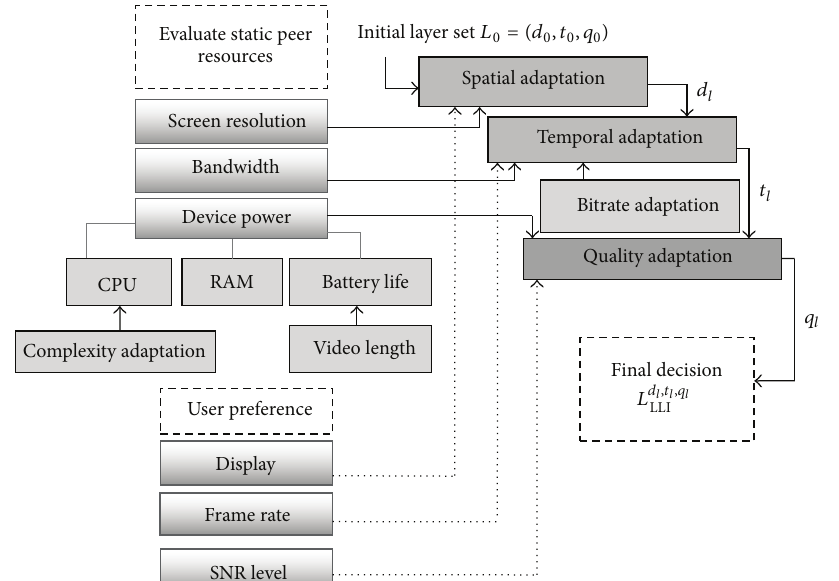
Figure 2: Algorithm Layer Level Initialization (LLI).